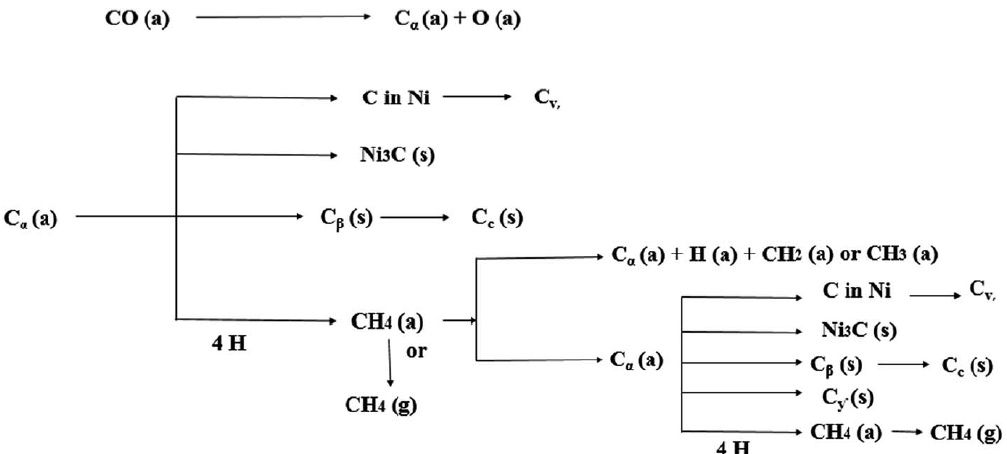
Figure 10. Mechanism of carbon formation at the catalyst surface. Reprinted with permission from Ref. [6]. Copyright 2016 Royal Society of Chemistry.